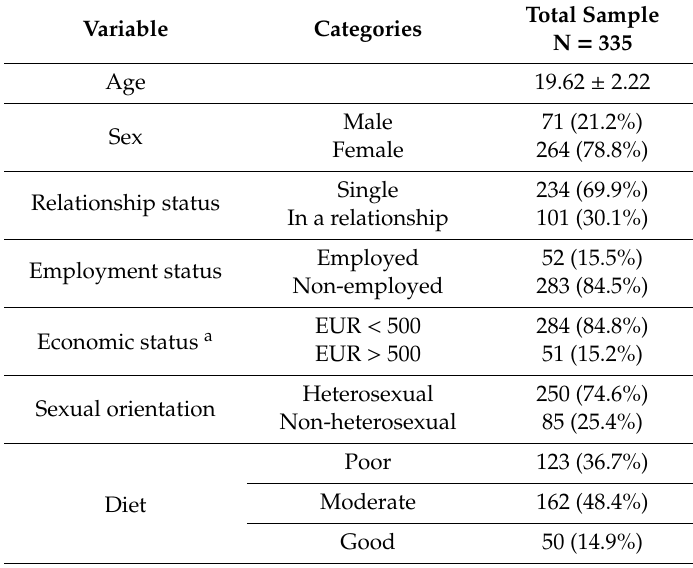
Table 1. Sociodemographic and lifestyle characteristics of the